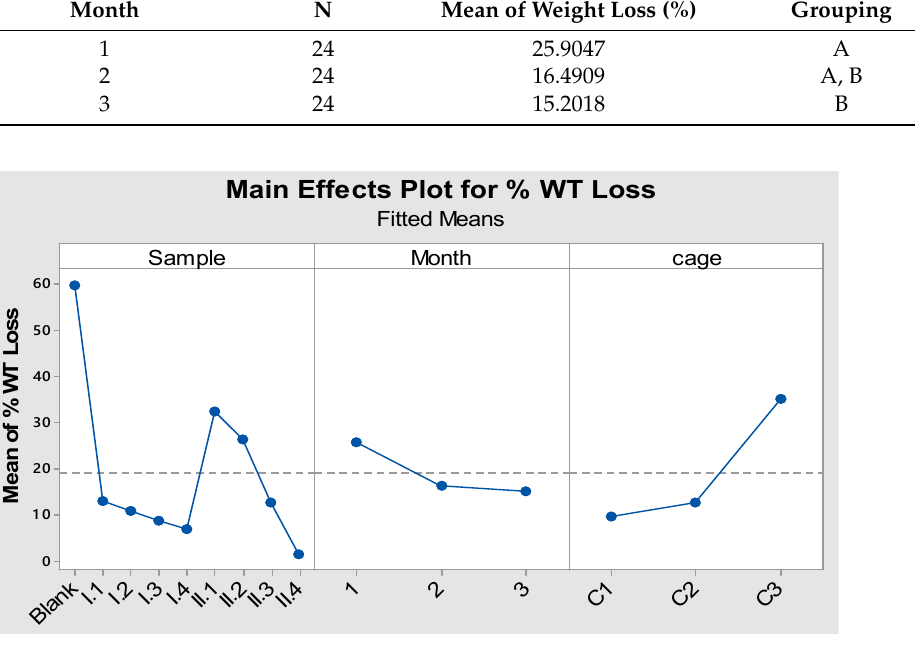
Table 4. Analysis of variance for the percentage of weight loss.